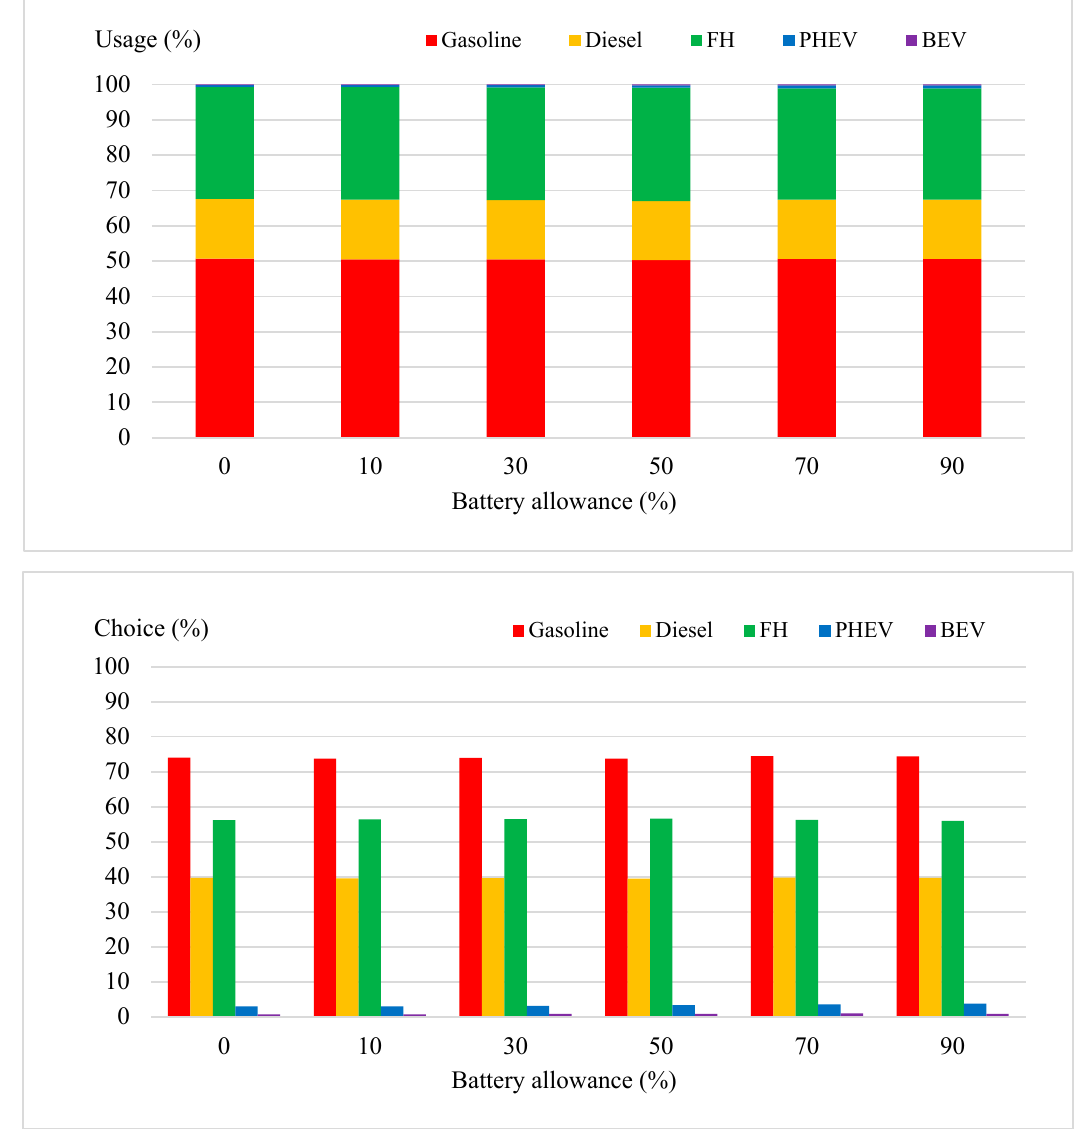
Figure A1. Market simulation results (Scenario A: Current Korean energy mix).